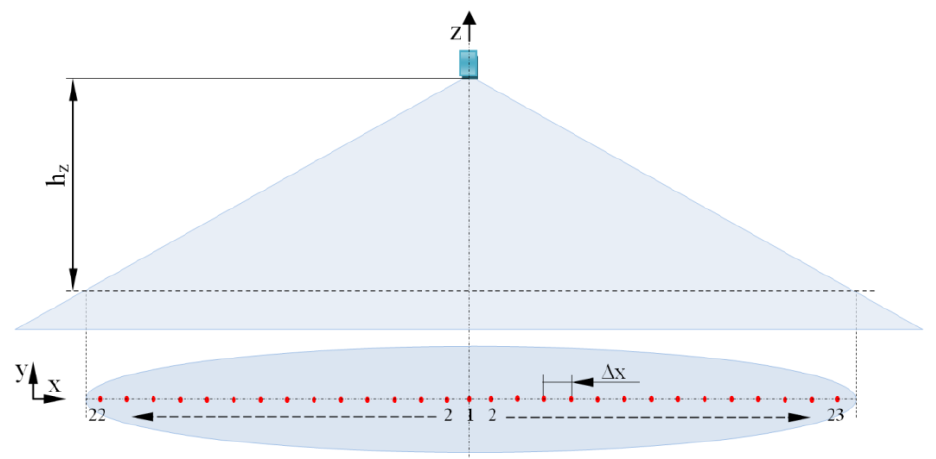
Figure 3. Diagram of the stream with marked 2D-PDA measurement points. Note: h z , measuring distance from the nozzle; x, measuring step.